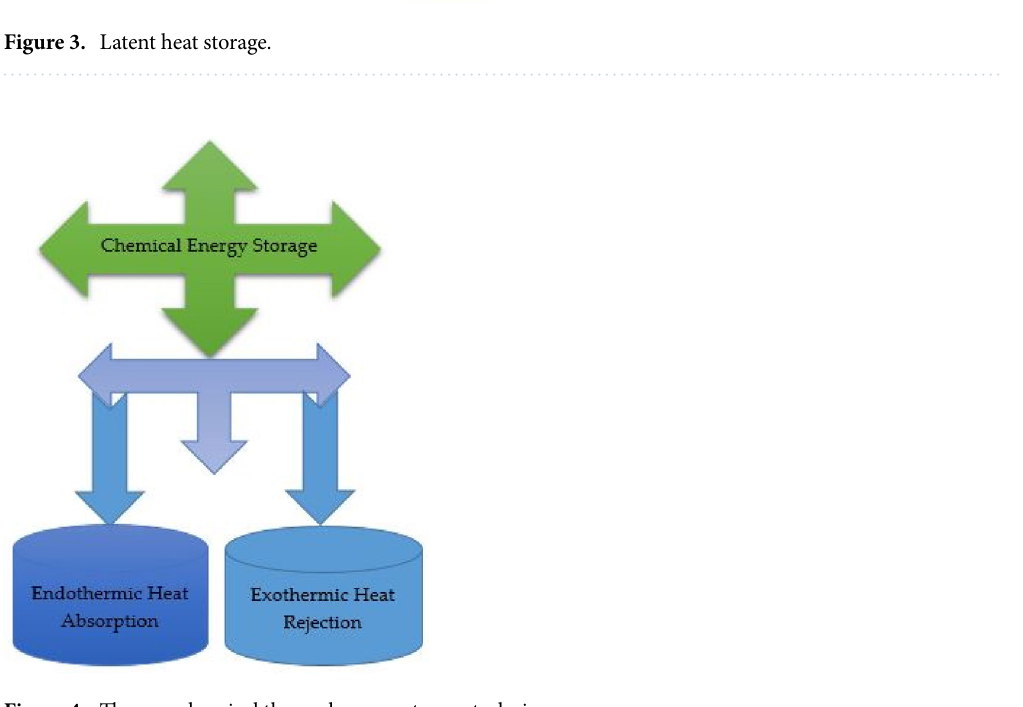
Figure 4. Thermo-chemical thermal energy storage